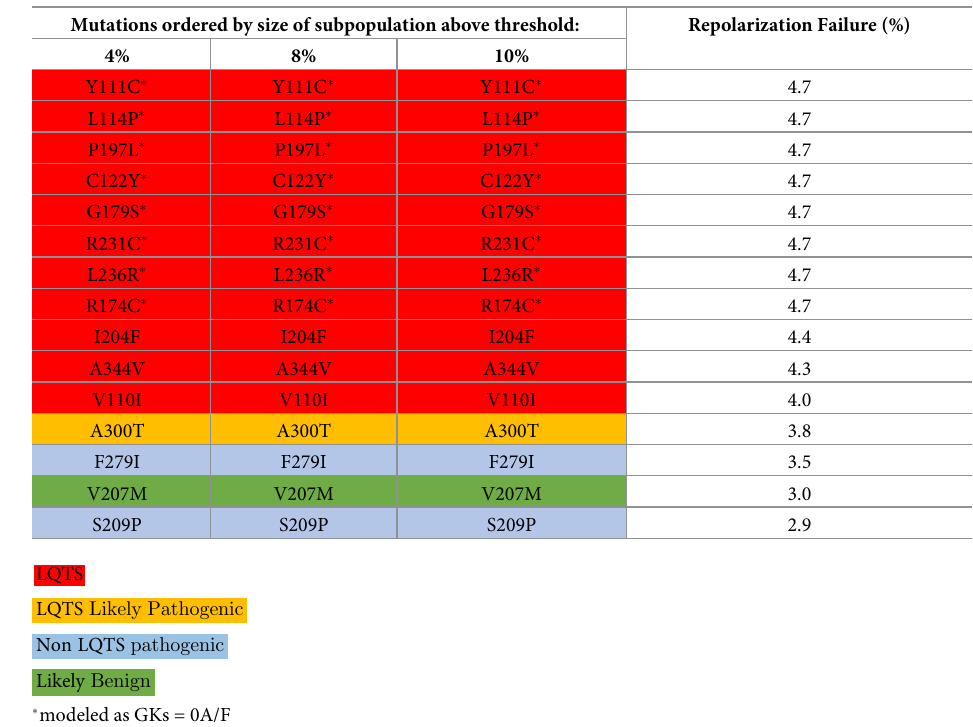
in the scatter plot. The model cells that met all three criteria above the 4% threshold are highlighted in red for the I knockout, yellow for the F278I mutation, and green for the Ks V207M mutation. All cells below the threshold criteria are indicated by a grey dot. Comparing the most severe mutant (0 G ) and a low severity mutation (V207M), there is a much- Ks increased spread in cellular outputs (grey and colored) for the severe mutation. This spread is due to the greater change in AP behavior, compared to WT, for each cell in the severe mutant population. Additionally, there are many more highlighted red points for the severe knockout mutation, than green highlighted points for the predicted low severity mutation (V207M). The six KCNQ1 mutations which had insufficient current density to optimize the I model Ks (with either � 0% current density measured experimentally relative to WT, or V could not 1/2 be determined), have all been classified as pathogenic LQTS mutations in the ClinVar data- base. Four mutations (I204F, A344V, V110I, and A300T) classified as LQTS mutations (patho- genic or likely pathogenic) had sufficient experimental data to optimize a mutant I model. Ks Three of these mutations have all been observed to prolong patient QT interval and are classi- fied as pathogenic LQTS in the ClinVar database (I204F, A344V, V110I). Additionally, A300T has been observed to prolong the QT interval in a clinical study, but it is either a recessive vari- ant or has incomplete penetrance in patients [36]. These 4 mutant populations, as well as the population with 0 G , were predicted to fall into the highest severity stratification in our Ks computational analysis, as shown in Fig 3A. One mutation included in TS1 is classified as a likely benign variant in the ClinVar database (V207M) and falls in the benign stratification shown in Fig 3A. Finally, there are two muta- tions which are classified as pathogenic, but for diseases other than LQT (non-LQT patho- genic) as follows: The S209P mutation falls at the lowest severity stratification of our analysis